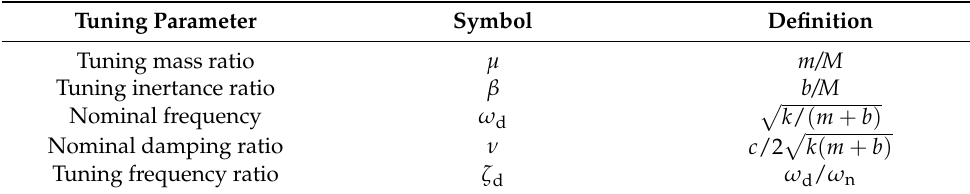
Table 1. Definitions of the tuning parameters of the